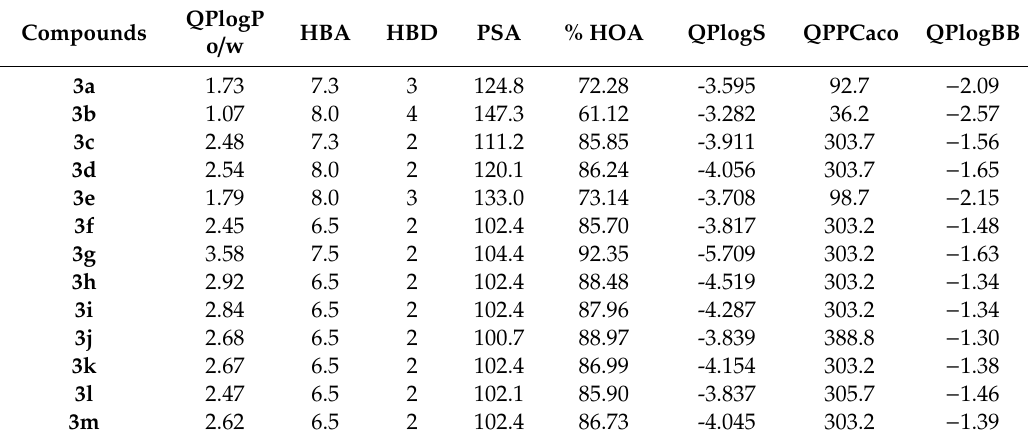
Table 2. ADME parameters predicted by computational